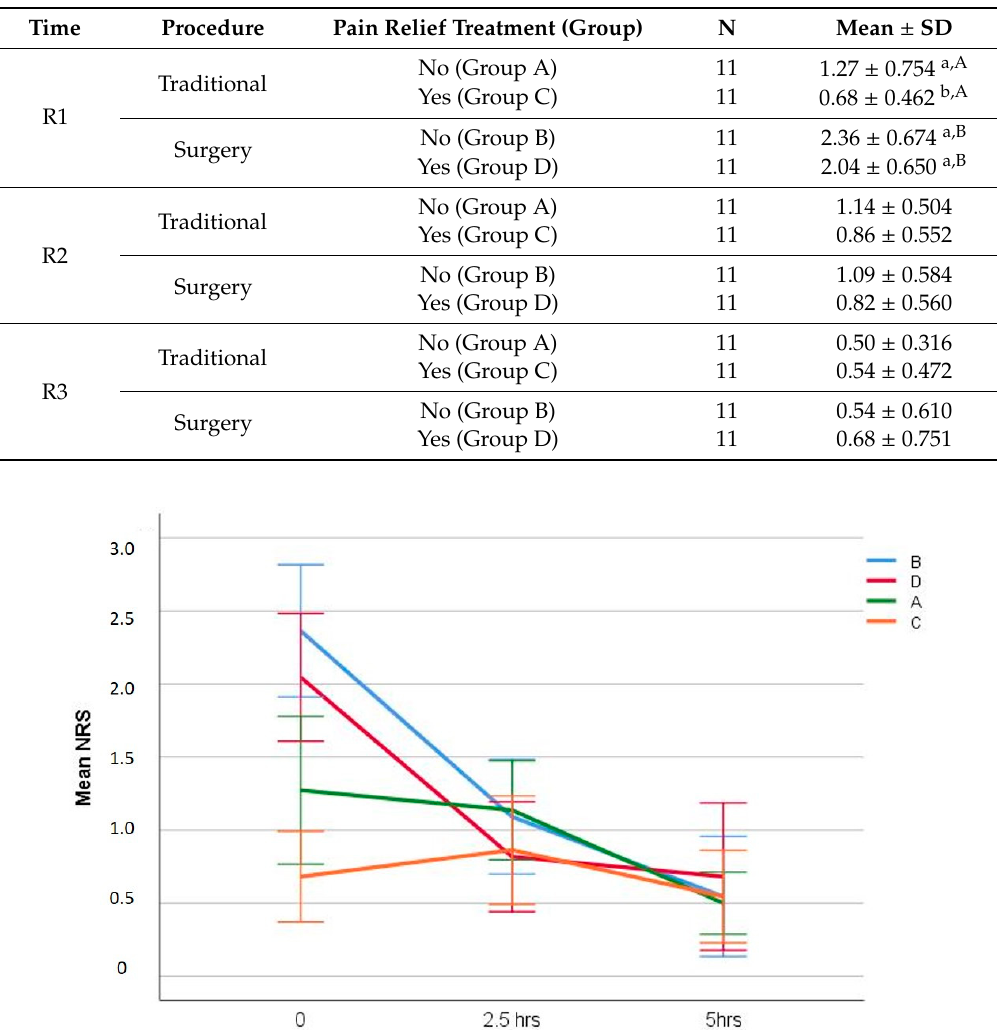
Table 1. Mean and SD of pain-related behaviour score (NRS) following tail docking by “Surgery” (conducted under general anaesthesia (GA) with stitching; Groups B and D) or “Traditional” (conducted without general anaesthesia or stitching; Groups A and C), with or without treatment with pain relief (PR) (yes or no, respectively). Only significant di ff erences were found for R1: a,b : di ff erent letters mean significant di ff erences between groups within procedure ( p < 0.05), A,B : di ff erent letters mean significant di ff erences between procedures ( p < 0.05).